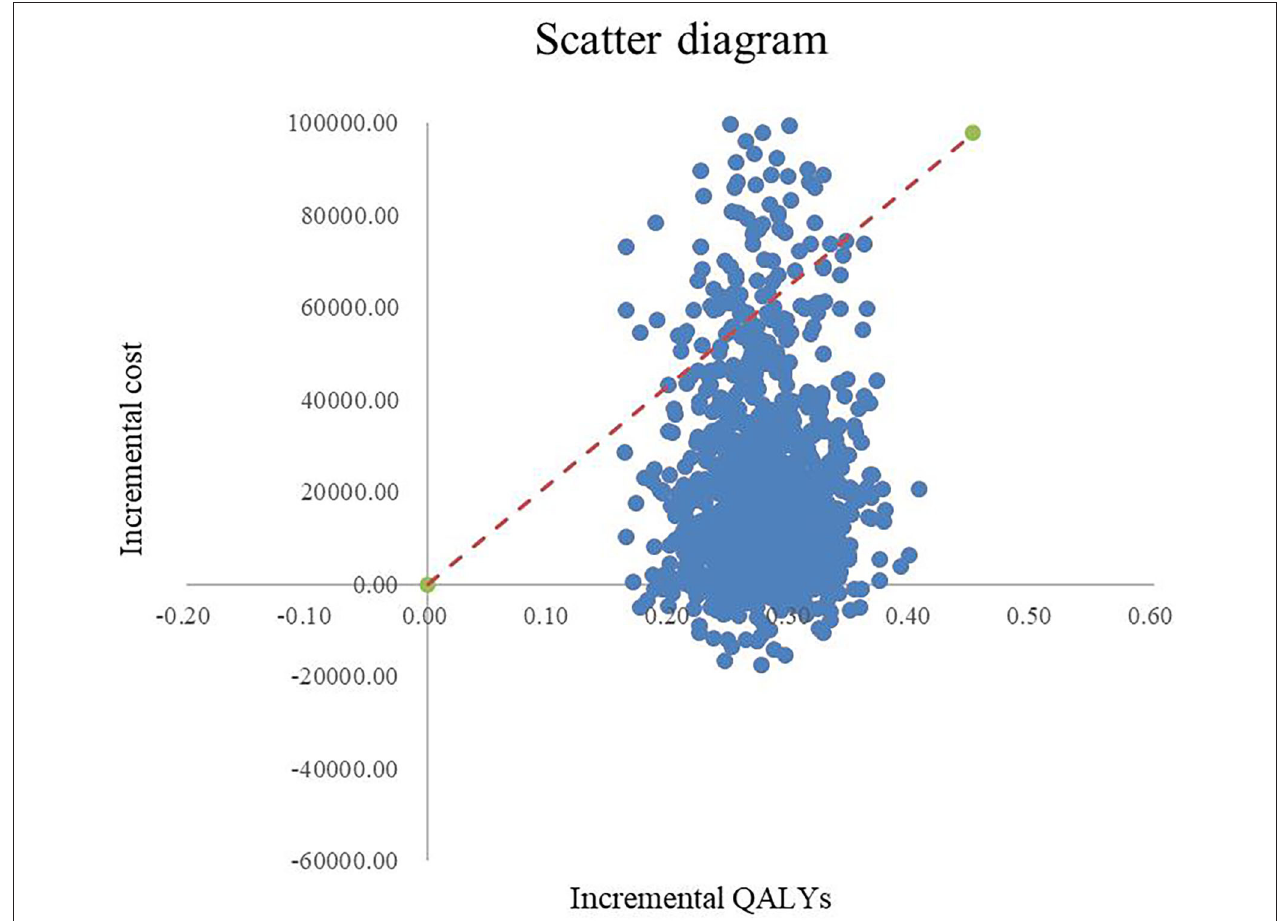
FIGURE 4 | Scatter